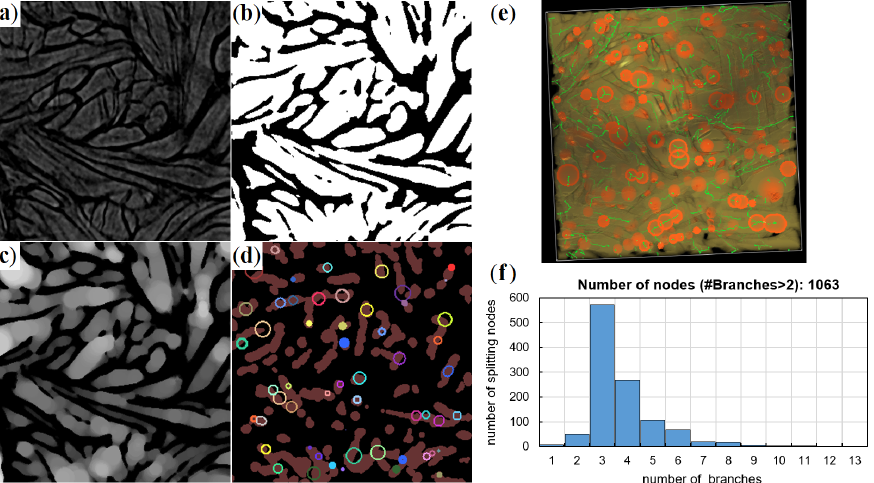
Figure 9. Workflow for branching point detection: ( a – d ) 2D slices from a 3D sub-volume of approxi- mately 1 mm edge length of the reconstructed µCT image of L2, back. In clockwise order: ( a ) original; ( b ) binarized with solid fiber-bundles; ( c ) spherical granulometry map (brighter = thicker); and ( d ) dilated skeleton (brown) with superimposed branching regions. Intersecting ones are united; ( e ): Vol- ume rendering of the same sub-volume. Fiber-bundles (brown) with skeleton (green) and branching regions (orange); ( f ): Histogram of branching valences for the sub-sample a–e. Here, Y nodes (3 branches) clearly